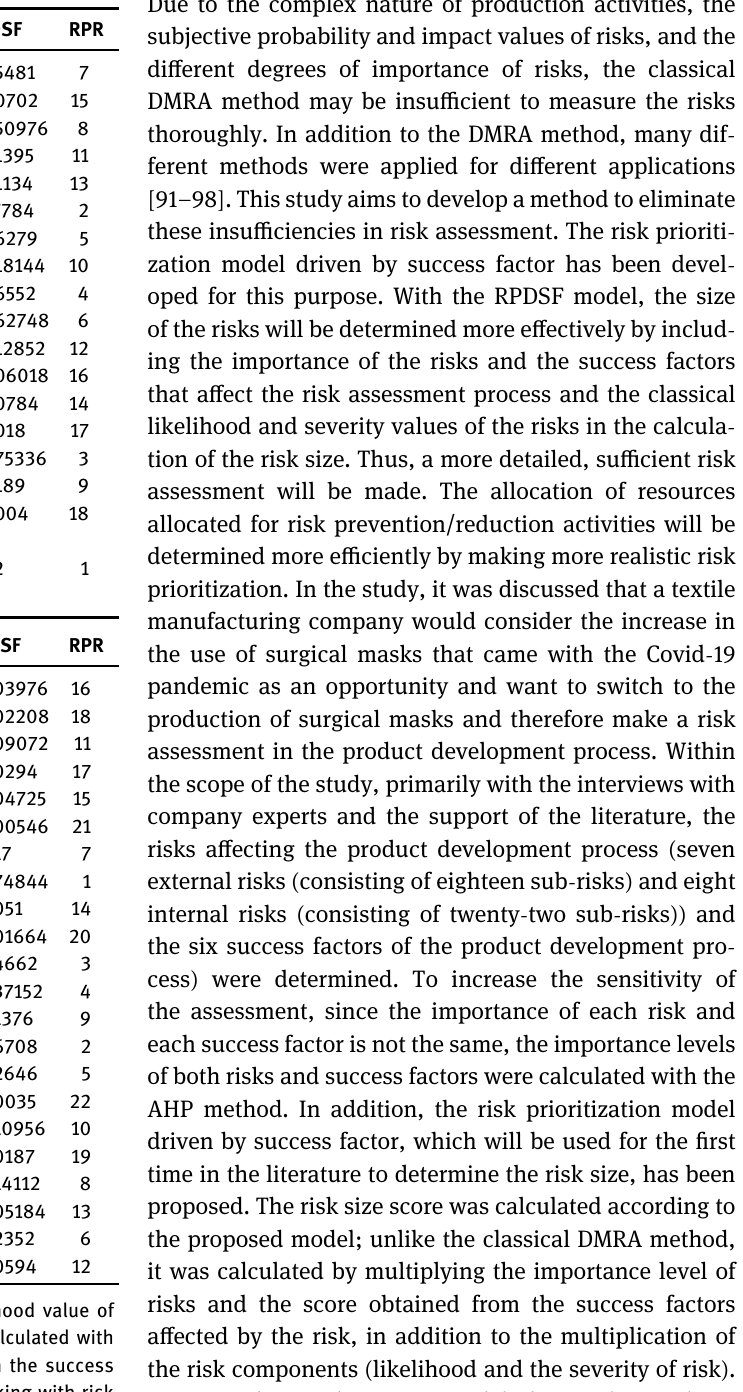
Table 10: Calculating risk sizes and determining risk priorities according to the RPDSF